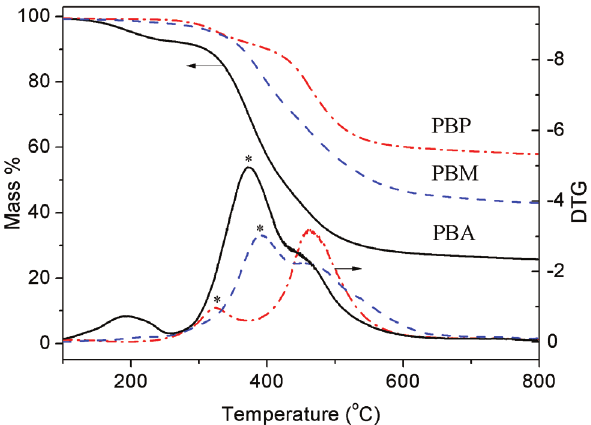
Fig. 1: TGA thermograms of polybenzoxazines